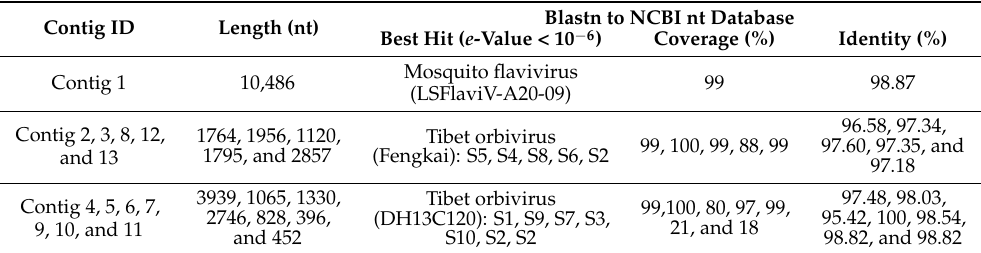
Table 1. Contigs with significant BLASTn similarities to known virus in supernatant from midge homogenate-inoculated cell culture.